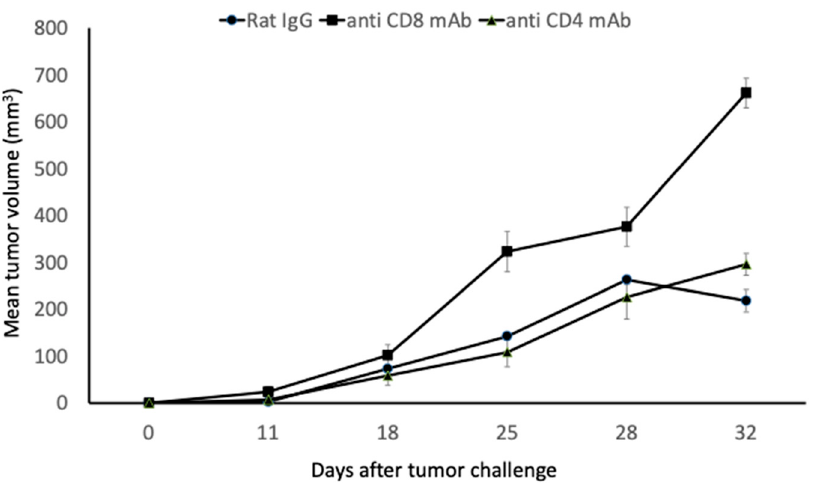
Figure 2. CD8 + T cells are effector cells for N -Pr-4- S -CAP-induced anti-melanoma immunity. Mice were injected with 100 µg of N -Pr-4- S -CAP or propylene glycol (100 µL into intraperitoneal lesion). Ninety days after injection, mice were depleted of CD4 + or CD8 + T cells by an intraperitoneal injection of 200 µg of GK1.5 ascites supernatant or 2.43 ascites supernatant, respectively, on days − 3, 4, 11 and 18. Mice in the antibody control group were injected with 200 µg of rat IgG. On day 0, 3.0 × 10 5 B16F1 melanoma cells in 0.1 mL of PBS were injected subcutaneously into the right flank of each of the C57BL/6J mice. Tumor diameters were measured every other day.